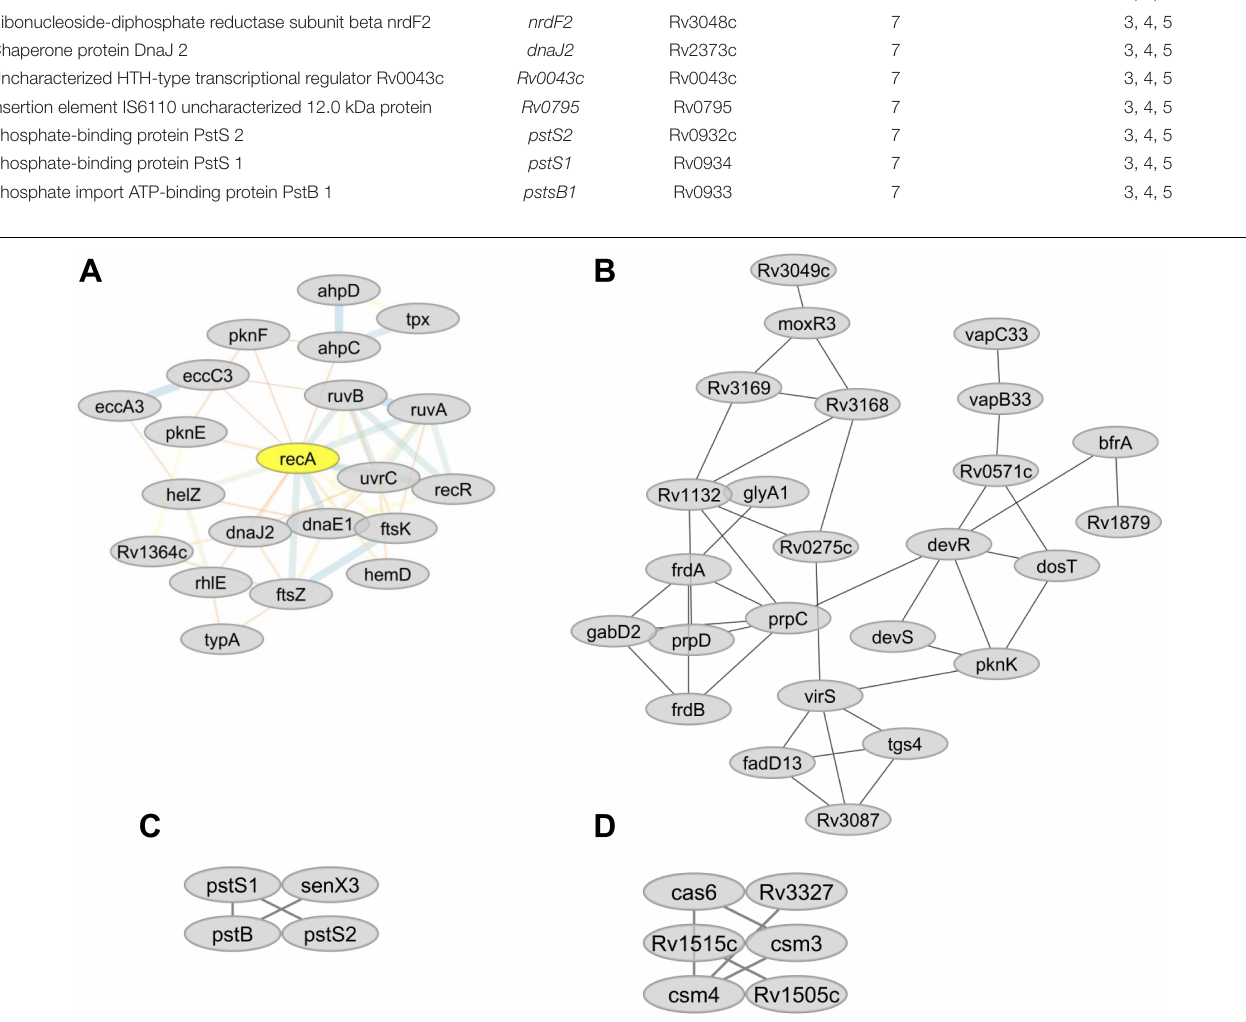
FIGURE 7 | (A) Predicted sub-network interactions for differentially abundant proteins involved in DNA repair. (B) Protein sub-network interaction among proteins involved in energy metabolism. (C) Predicted sub-network interaction for differentially abundant proteins involved in inorganic phosphate uptake. (D) Predicted sub-network interaction for differentially abundant proteins involved in CRISPR-Cas